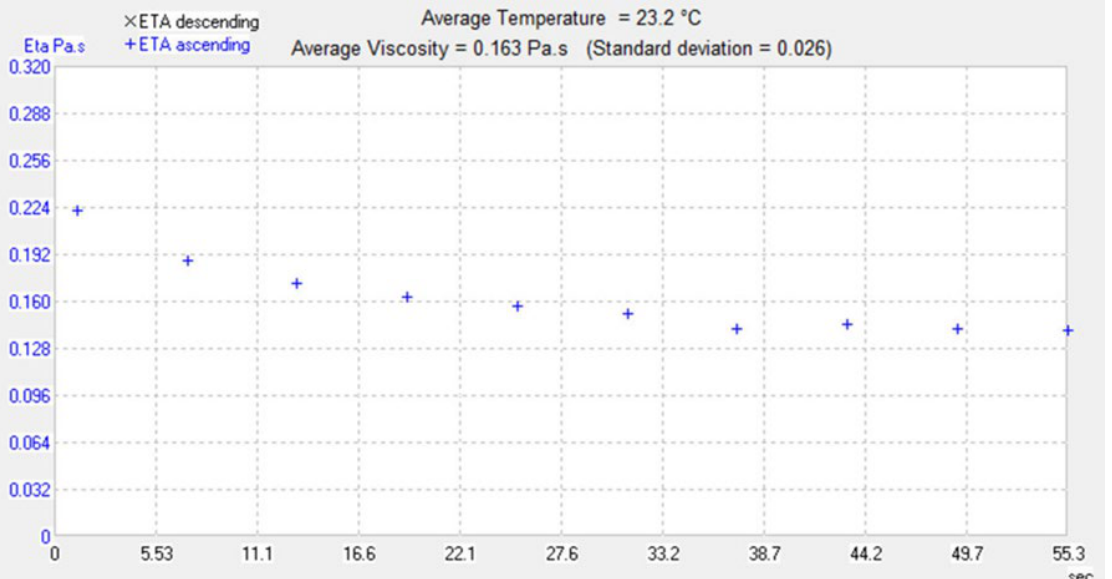
Figure 9. Ex vivo diffusion model. Ex vivo diffusion studies were performed on rat skin. ( A ) diffu- sion and release kinetics through rat skin. ( B ) Higuchi model. Data shown as means ± SD ( n = 3).